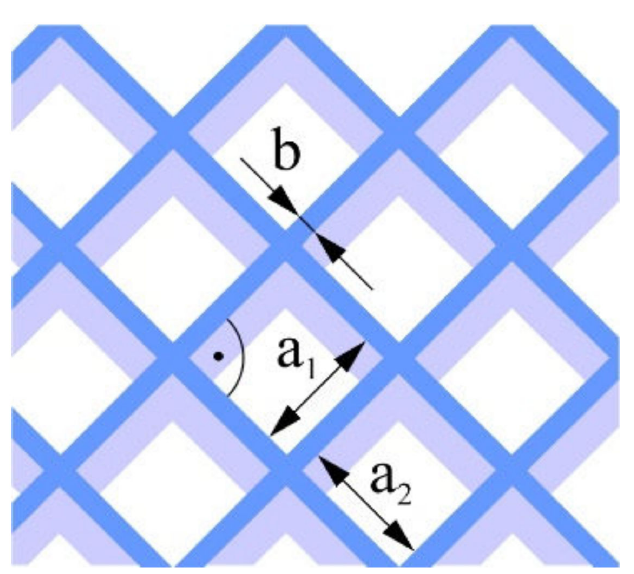
Figure 5. The used structure of the grid filling (b = 0.4mm, a 1 /a 2 =